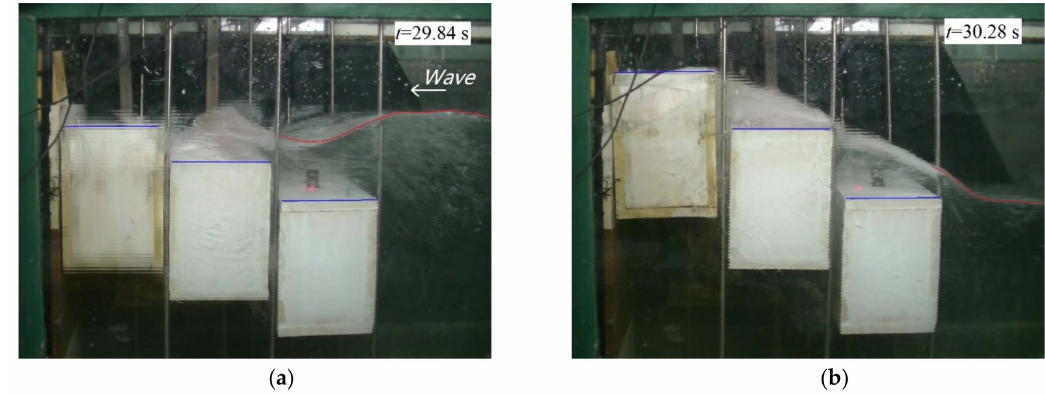
Figure 8. Snapshots of the wave–structure interaction for the case of T i = 1.8 s, h = 0.6 m, H i / L i = 0.06, L i = 3.82 m: ( a ) t = 29.84 s; ( b ) t = 30.28